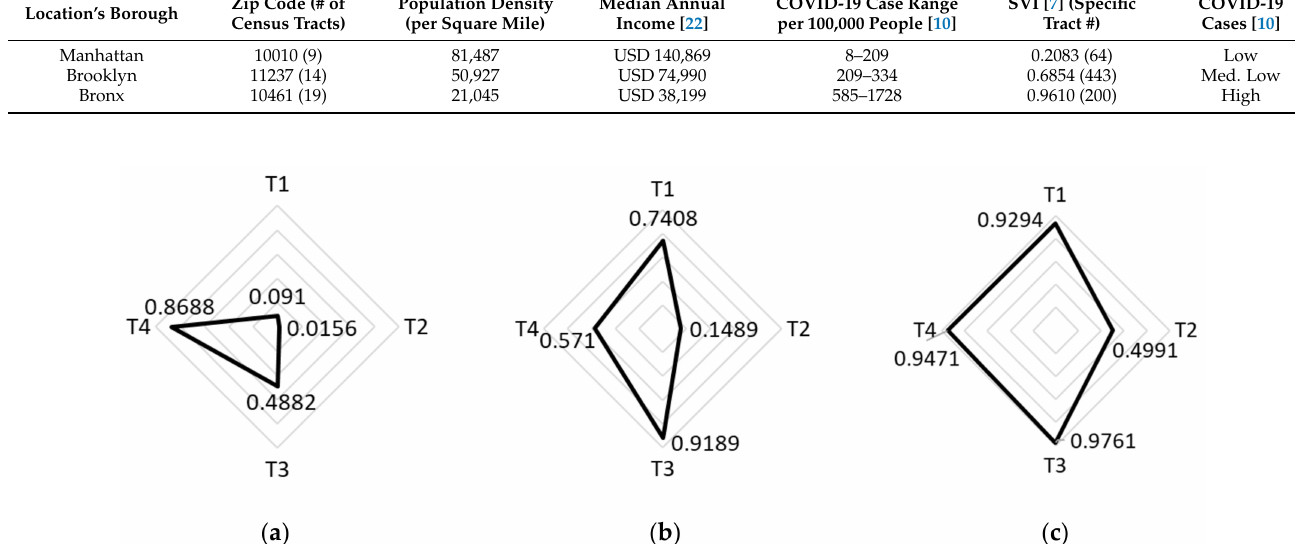
Figure 2. SVI by theme where T1 is socioeconomic status, T2 is household composition and disability, T3 is minority status and language, and T4 is housing type and transportation [7]: ( a ) Manhattan, Tract 64, SVI = 0.2083; ( b ) Brooklyn, Tract 443, SVI = 0.6854; ( c ) Bronx, Tract 200, SVI = 0.9610. # =